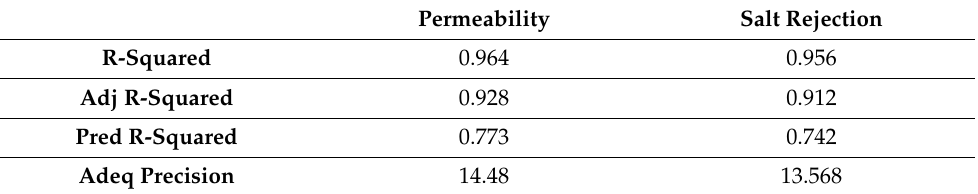
Table 7. The R-squared parameters for the permeability and salt rejection response models.